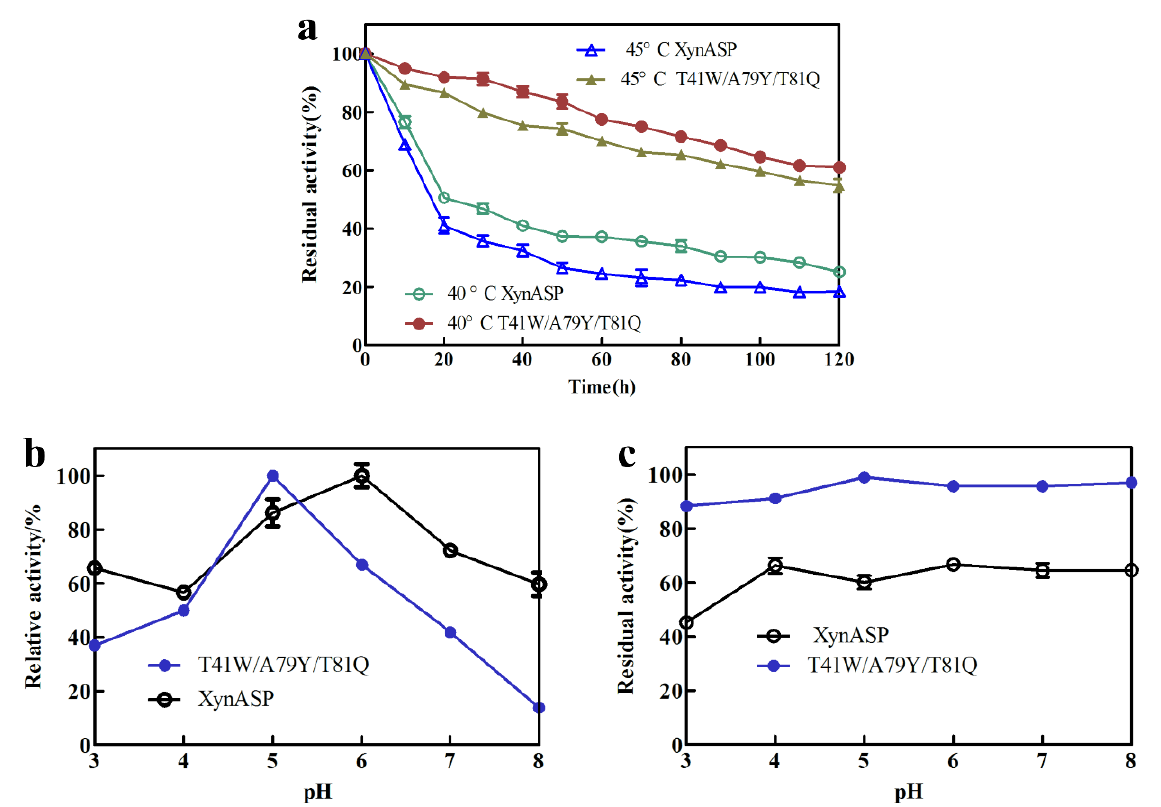
Figure 7. Effect of temperature on the stability ( a ), pH on the activity ( b ) and stability ( c ) for the wild-type and the mutant T41W/A79Y/T81Q. The data for the wild-type and T41W was adapted with permission from Ref. [28]. 2022, Bio Tech System.. The highest activity of each wild-type and mutant was set as 100%.